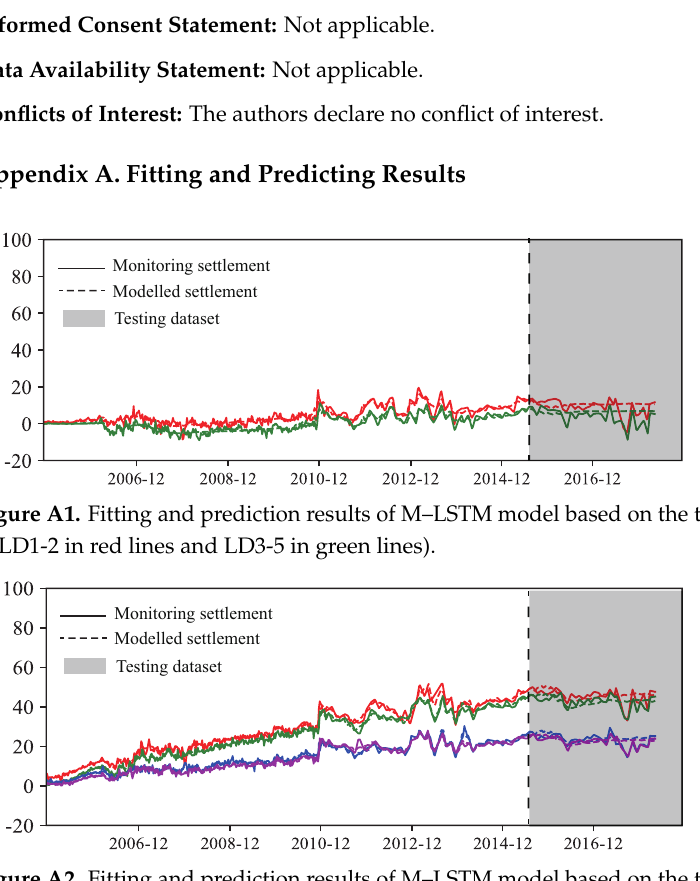
Figure A2. Fitting and prediction results of M–LSTM model based on the training datasets in Cluster 2 (LD2-2 in red, LD3-3 in green, LD5-4 in blue, and LD6-3 in purple lines,